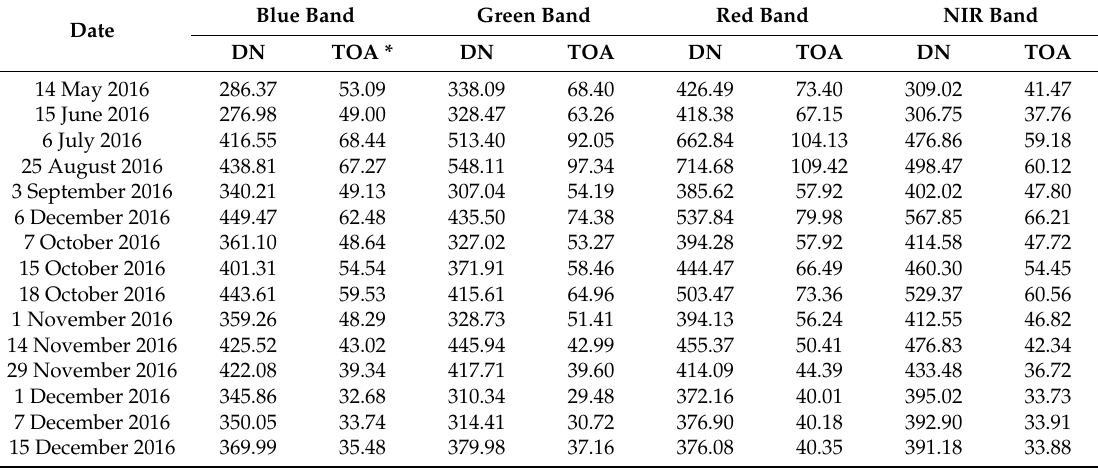
Table 8. Mean TOA radiance and DN for every GF-4/PMS image.